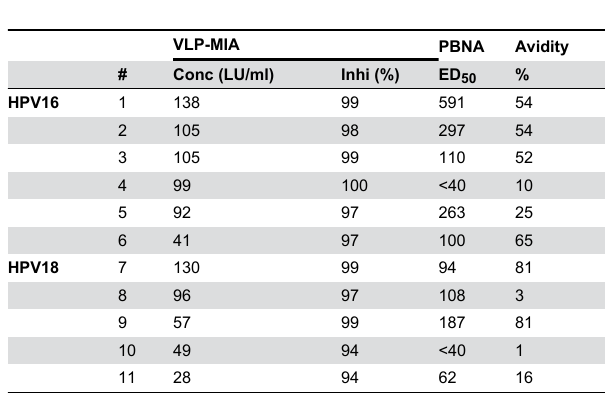
Table 2. HPV16 and 18 antibody characteristics of single- positive sera induced by HPV infection.